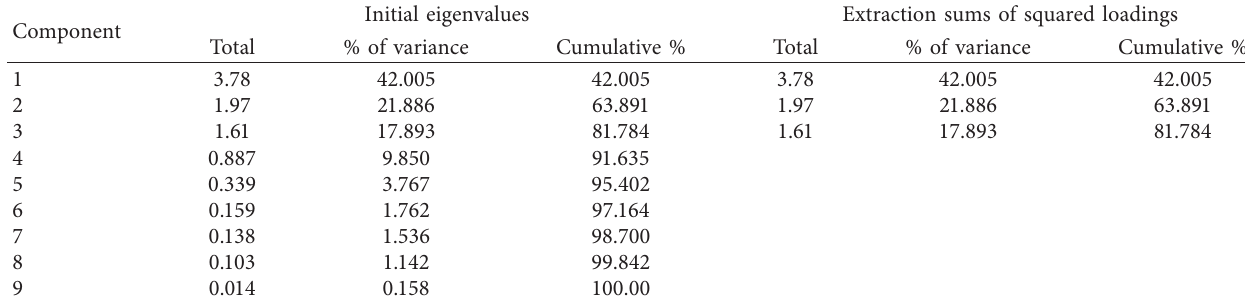
Table 4: Total variance explained in the PCA